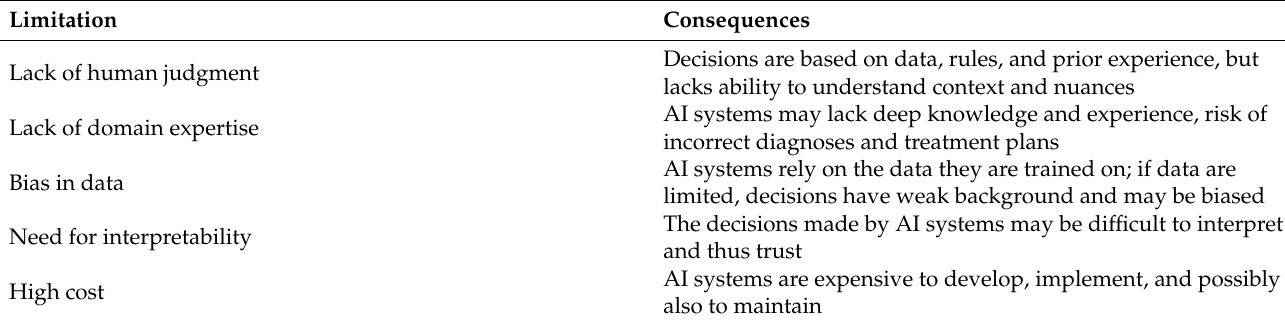
Table 1. Limitations of AI in medical